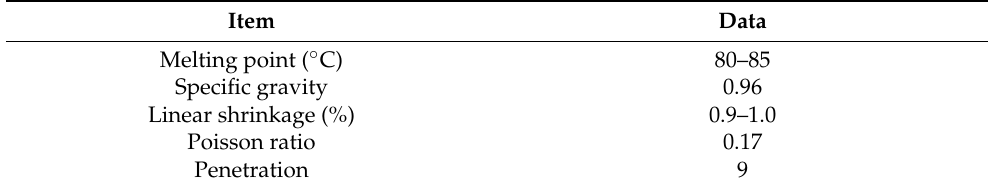
Figure 7. Details of the wax injection molding simulation conditions; ( a ) configuration of the simu- lation model, ( b ) finite element mesh of profiled conformal cooling channels, filling system, and injection-molded parts, ( c ) viscosity chart, and ( d ) PVT diagram of the molding materials. Table 1. Main properties of the casting materials.